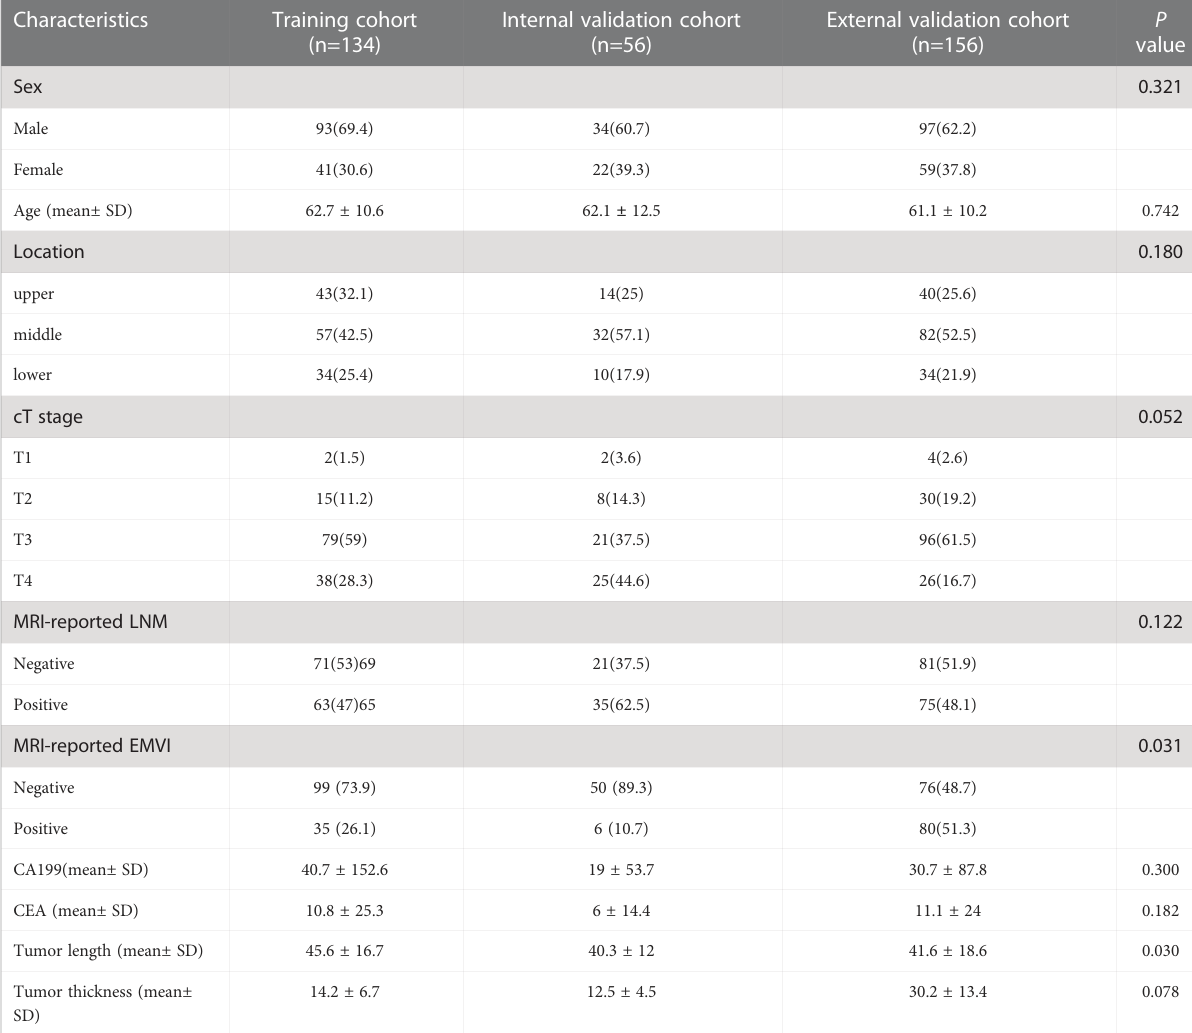
TABLE 1 Baseline characteristics of the study